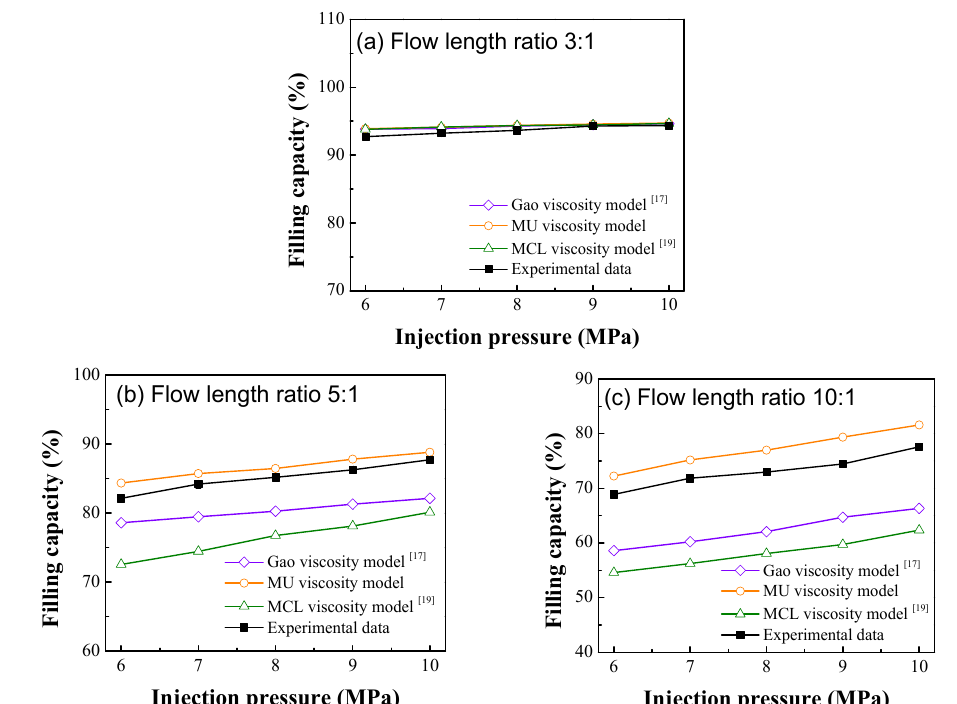
Figure 4. Simulation results and experimental results of microgroove filling capacities at di ff erent flow length ratios ( a ) flow length ratio 3:1; ( b ) flow length ratio 5:1; ( c ) flow length ratio 10:1.